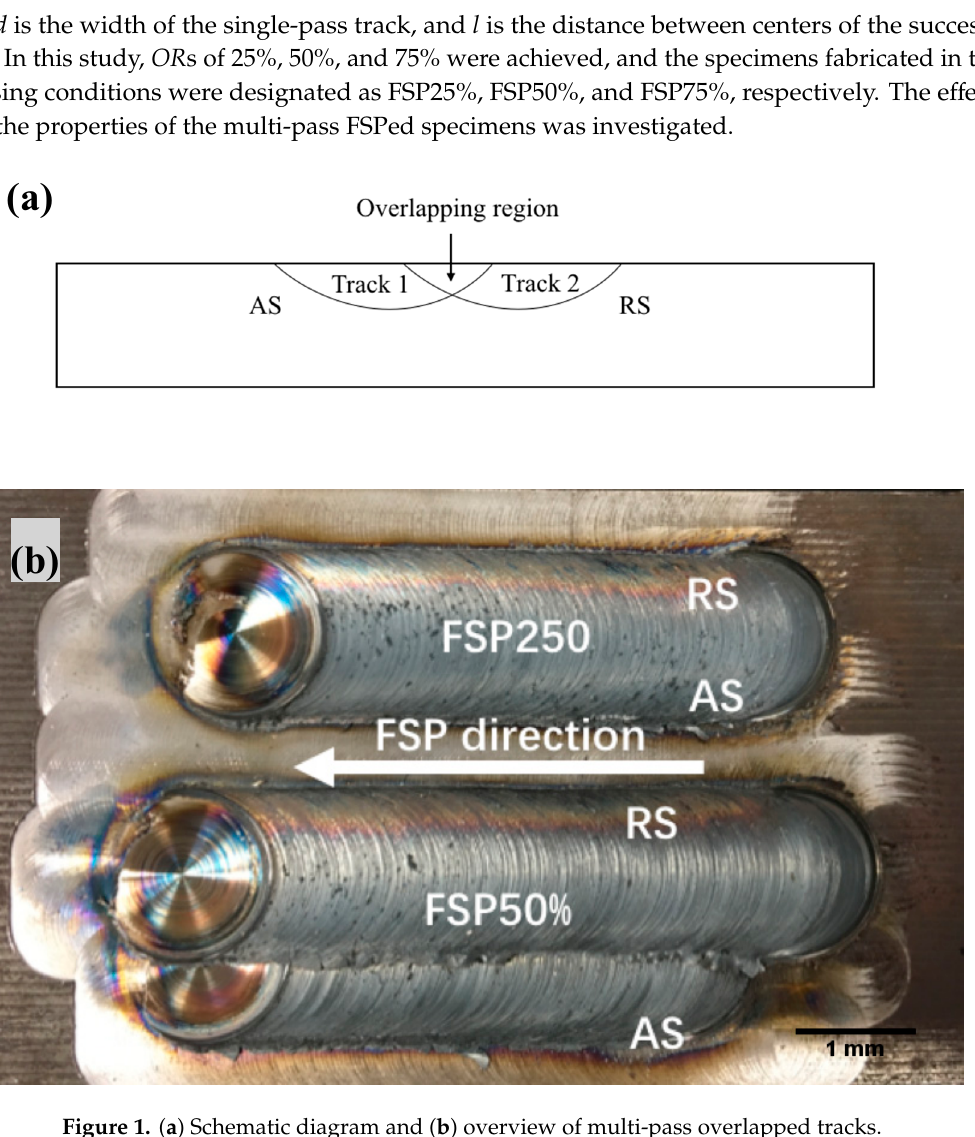
Figure 1. ( a ) Schematic diagram and ( b ) overview of multi-pass overlapped tracks.